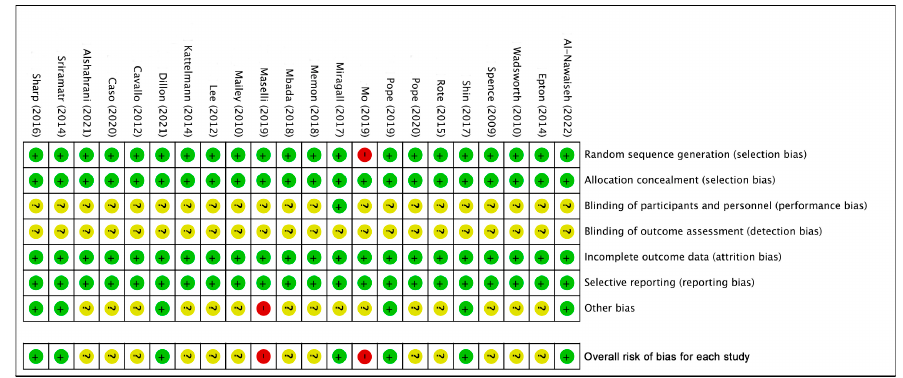
Figure 3. Risk of bias summary for included studies (Green: low risk of bias; yellow: unclear risk of bias; red: high risk of bias) [36,37,44–63].